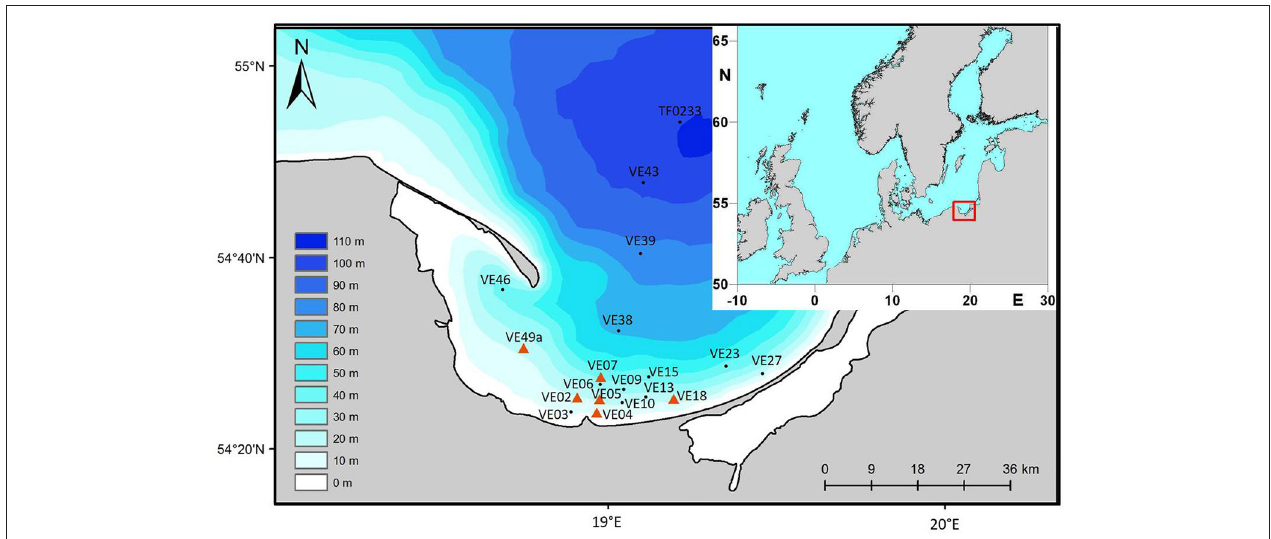
FIGURE 1 | Location of the sampling stations in the Bay of Gdansk, southern Baltic Sea. The inlay shows a map of Northern Europe, the rectangle marks the Bay of Gdansk.